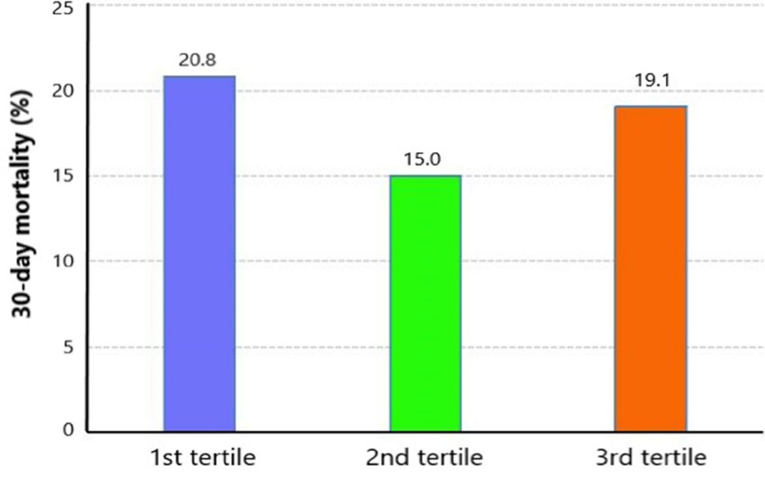
Figure 2. Distribution of initial serum magnesium level in included TBI patients.